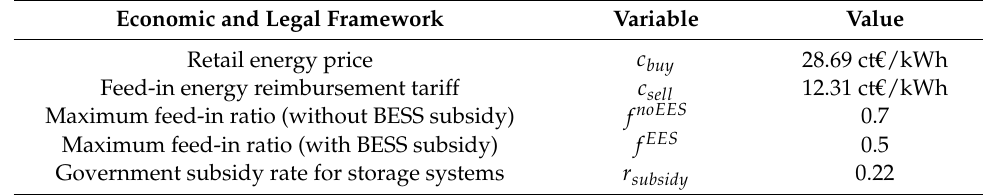
Table 4. Remuneration and retail energy prices for households in Germany (2016), and legal framework for PV-grid